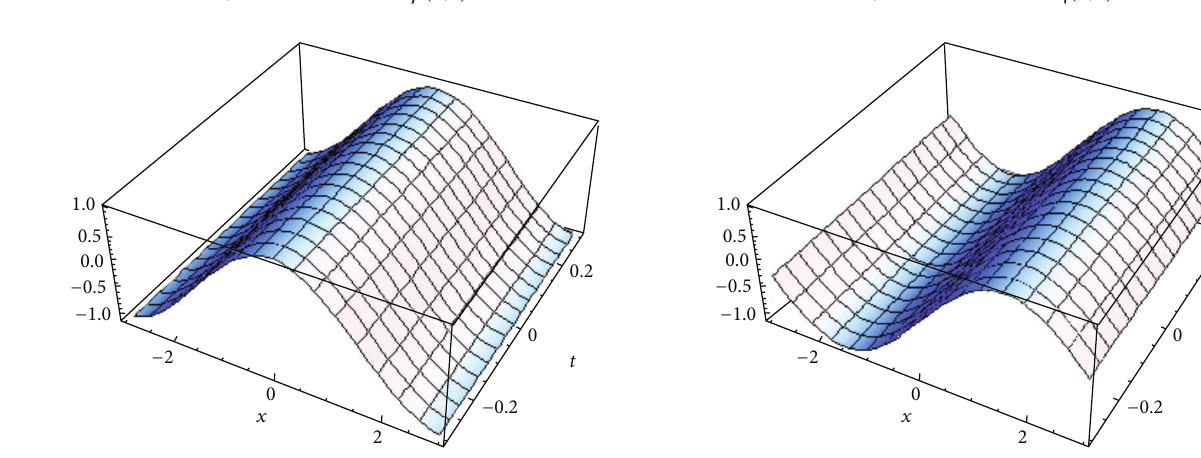
Figure 3: 3D, OHAM solution of 𝜂(𝑥,𝑡) at 𝑡 = 0.1 .